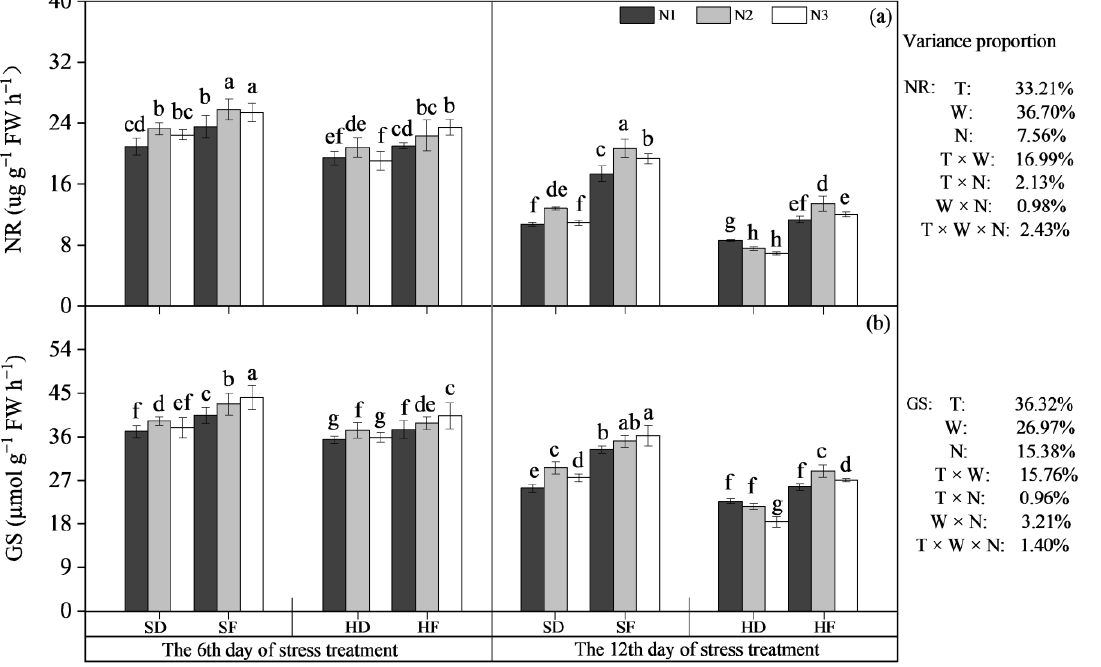
Figure 5. Effects of N application on the activities of nitrate reductase (NR, a ) and glutamine synthetase (GS, b ) in the leaves of wheat under short-term heat, drought and combined stress after anthesis. SD: suitable temperature + drought stress; HD: heat + drought stress; HF: heat stress + full watering; SF: suitable temperature + full watering. T: temperature; W: watering; N: nitrogen. The values are the means ± standard deviation, n = 5. Different lowercase letters indicate statistically significant differences ( p < 0.05). The right side of the figure shows the proportion of variance explained by each factor and interaction.